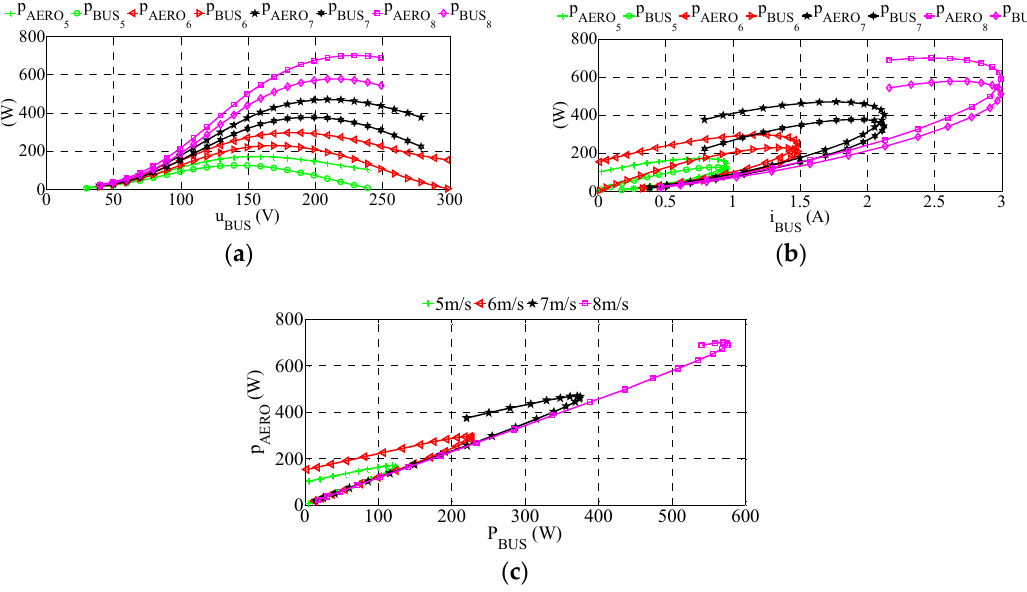
Figure 2. ( a ) Aerodynamic power p AERO and electrical power p BUS based on the DC bus voltage u BUS ; ( b ) Aerodynamic power p AERO and electrical power p BUS based on the DC bus current i BUS ; ( c ) Aerodynamic power p AERO based on power p BUS .